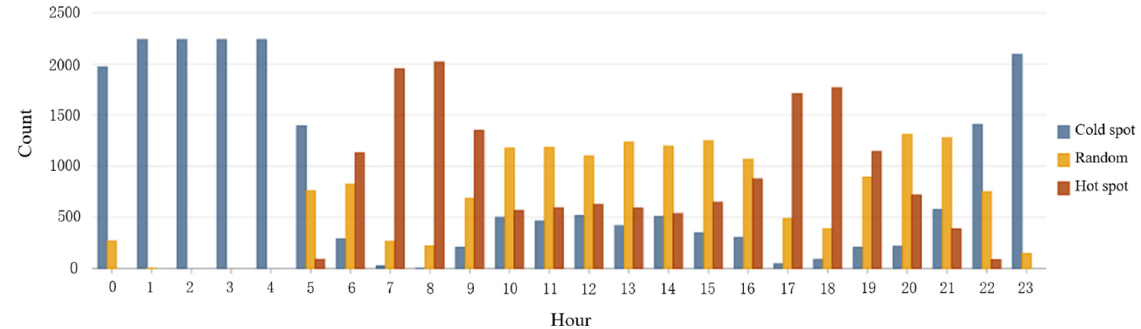
Figure 9. Statistical result of space–time cubes with cold-hot spot.